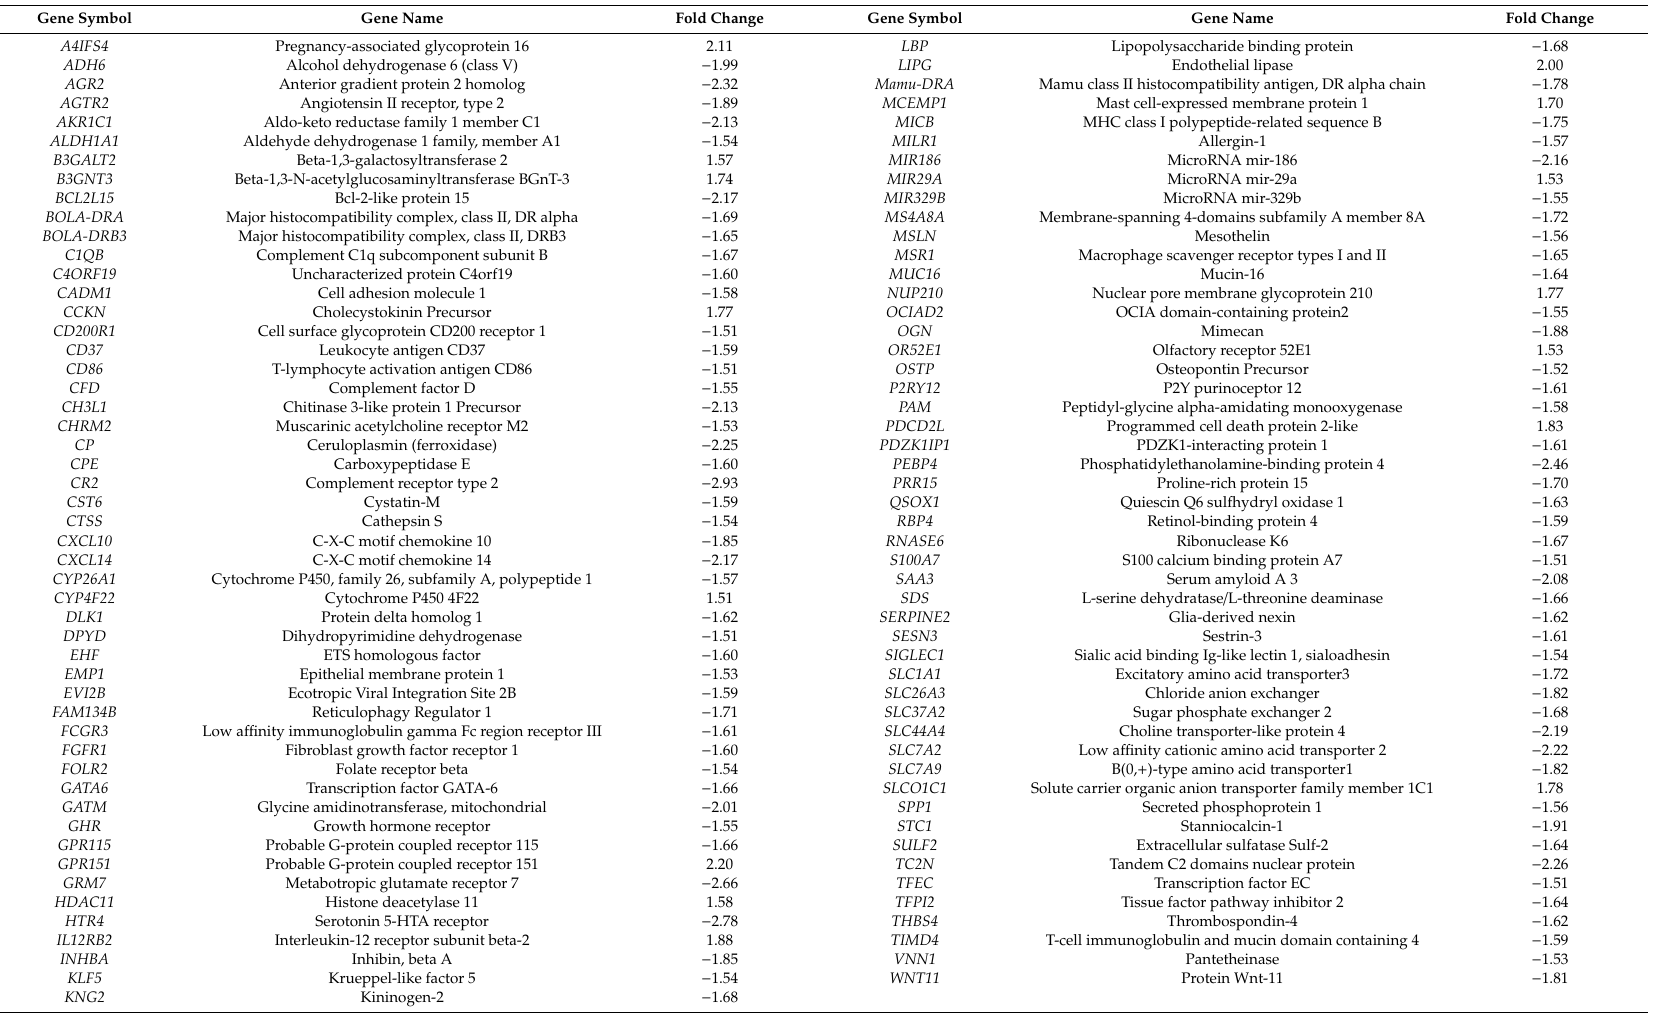
Table 1. Placentomal mRNA expression for selected genes identified using the microarray analysis in nutrient restricted (NR) non-intrauterine growth restriction (non-IUGR) compared to NR IUGR pregnancies ( p <